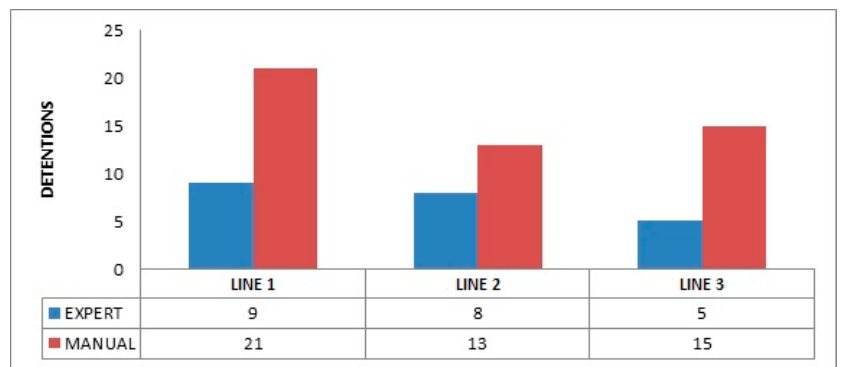
Figure 7. Daily detentions in both modalities, by lines.